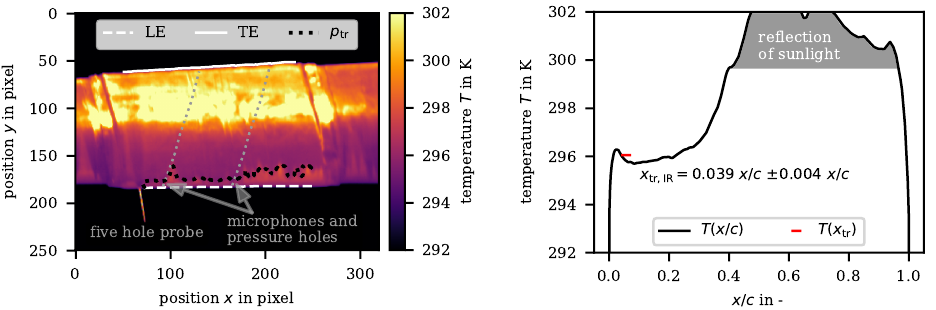
Figure 16. Thermographic flow visualization measurement at 10:16:45 (SCADA time). Left : Thermographic image. Right : x-y-plot of